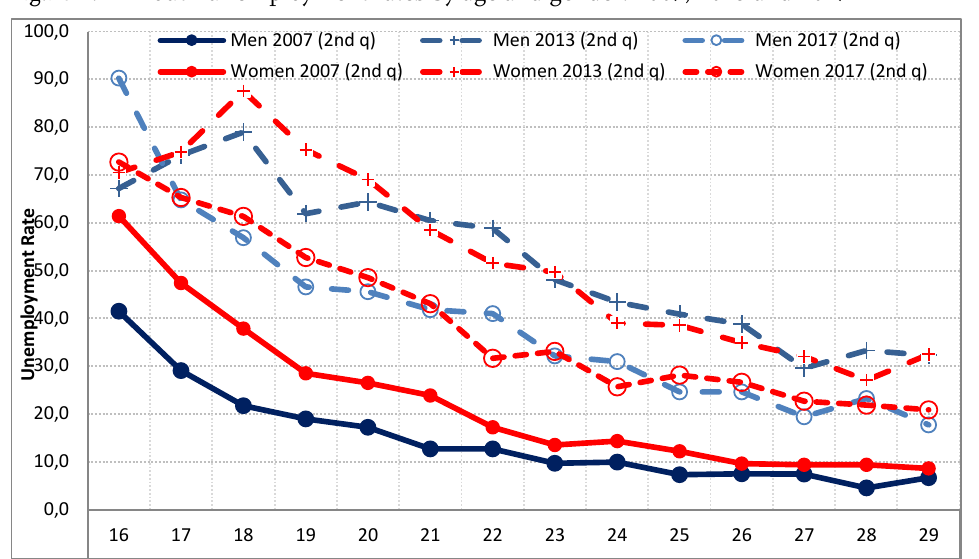
Source: Spanish Labour Force Survey (Encuesta de Población Activa, EPA), 2005-2017. Instituto Nacional de Figure 2 : Youth unemployment rates by age and gender: 2007, 2013 and 2017